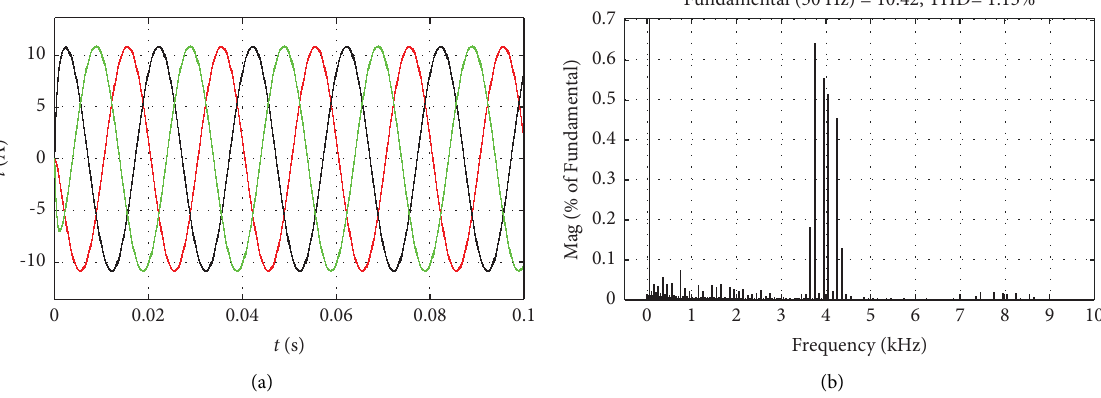
Figure 10: Te waveform of the grid-connected current with a flter and its spectrum. (a) Waveform of the grid-connected current and (b) frequency spectrum of the grid-connected